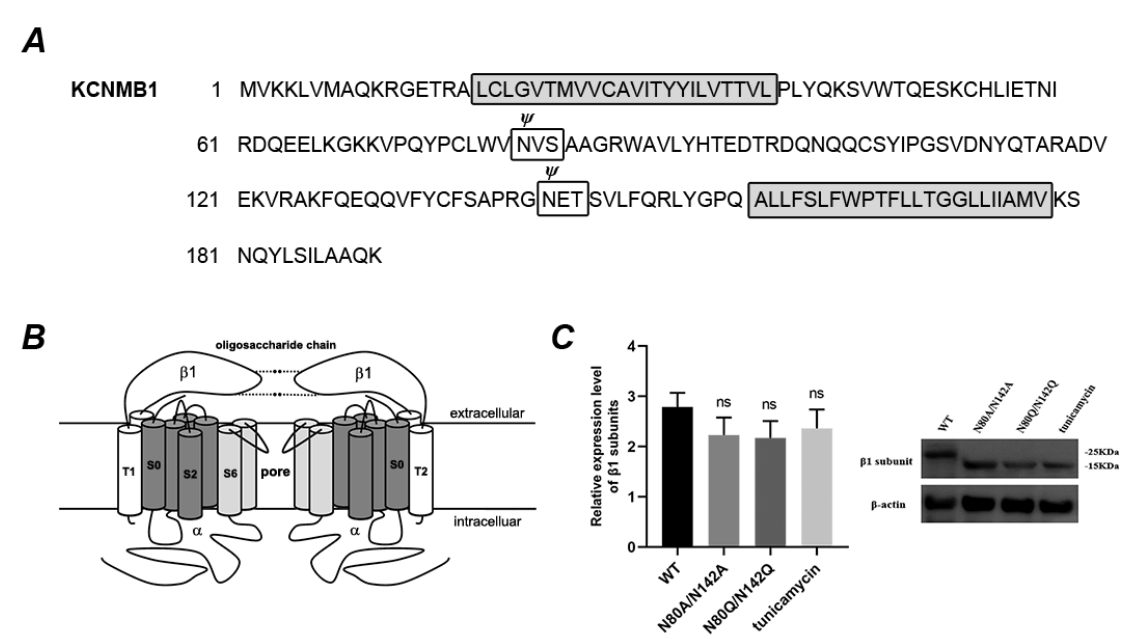
Figure 1. Molecular properties of BK channel β 1-subunit. (A) The primary structure of a subunit protein, including N-glycosylation site (white boxes) and transmembrane segment (gray boxes). (B) Model of BK ( α + β 1) channels (two of the four subunits are shown), including segments of α subunits, extracellular loop of β 1 and oligosaccharide chains on β 1 (dotted line). (C) Western blot showing β 1-subunit. Molecular mass of the ~25 kDa immunoreactive band was wild-type β 1-subunit (lane 1). Immunoreactive protein, with a molecular mass of ~20 kDa was double glycosylation site mutant β 1 N80A/N142A (lane 2) and β 1 N80Q/N142Q (lane 3). The immunoreactive band with a molecular mass of ~20 kDa on lane 4 was the β 1-subunit by treatment with tunicamycin. There was no significant difference among the wild-type β 1 subunit, N80A/N142A mutant, N80Q/N142Q mutant and the tunicamycin treated group in protein relative expression level (p >